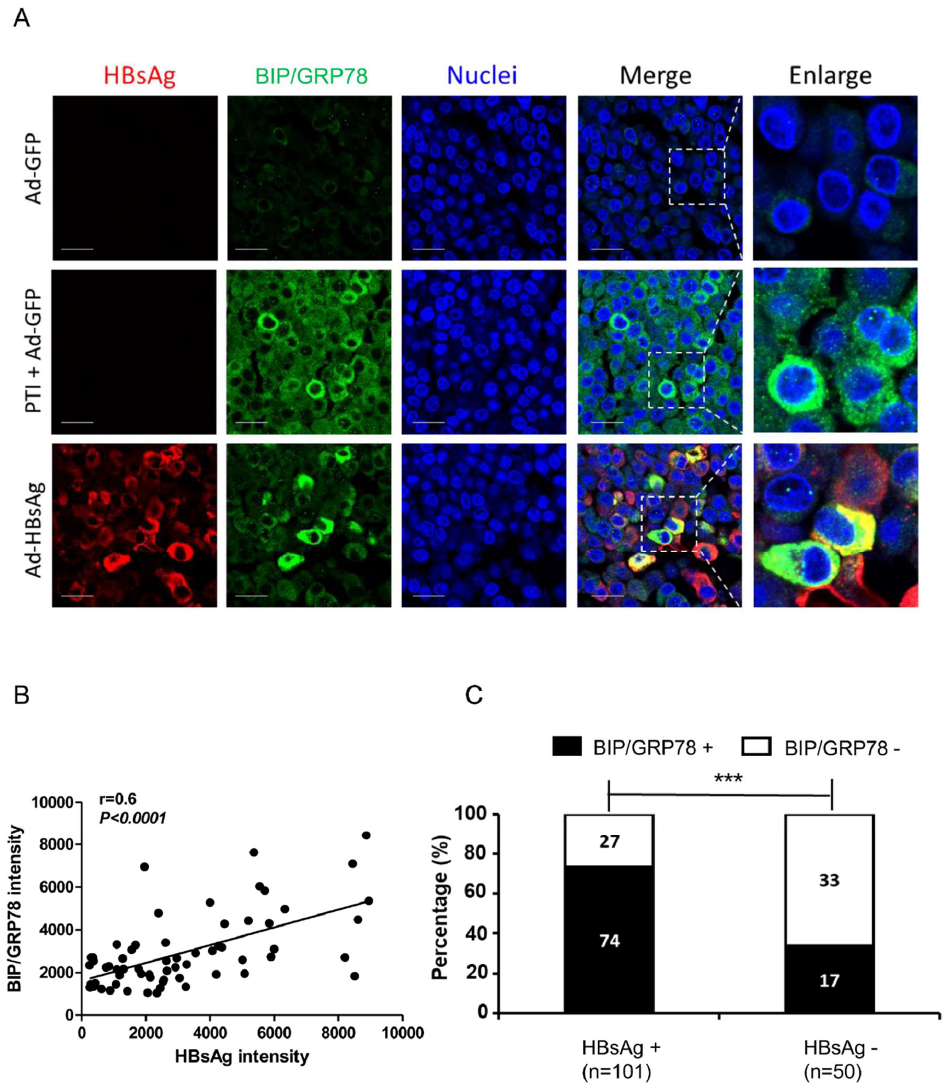
Figure 3. Co-localization of ER stress marker BIP/GRP78 and HBsAg. HepG2-NTCP cells were paraffin-embedded after transduction with Ad-GFP, Ad-HBsAg or treatment with PTI for six hours. ( A ) Immunofluorescent staining with anti-HBsAg and anti-BIP/GRP78 antibodies were performed three days after transduction. Nuclei were stained with Hoechst 33342. Scale bar represents 20 μm. ( B ) In Ad-HBsAg-transduced cells, the HBsAg and BIP/GRP78 intensities in each cell were measured, and their correlation was evaluated. ( C ) Ad-HBsAg transduced cells were grouped by HBsAg staining and analyzed for BIP/GRP78 signals. The ratio of BIP/GRP78 positive vs. negative cells was determined and shown. All results were confirmed by three independent experiments. *** p < 0.001.